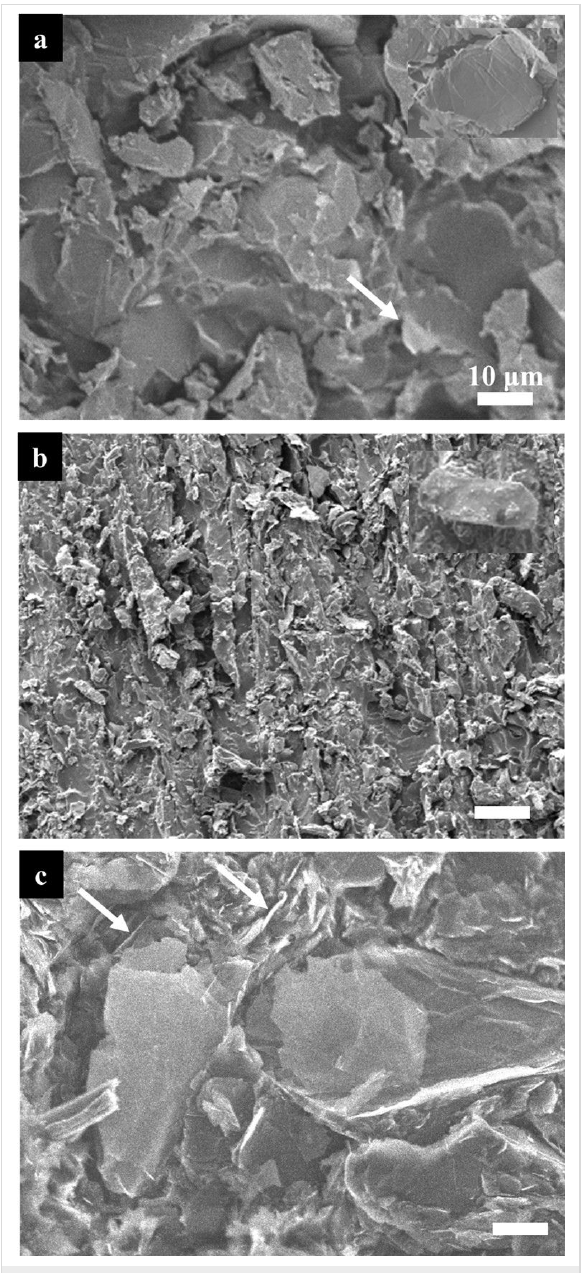
Figure 1: SEM images of graphene nanoplatelet- (a) and graphite- (b) loaded single-filler epoxy composites. (c) GNP–graphite hybrid composite. The arrows indicate edge-on GNP filler in (a) and